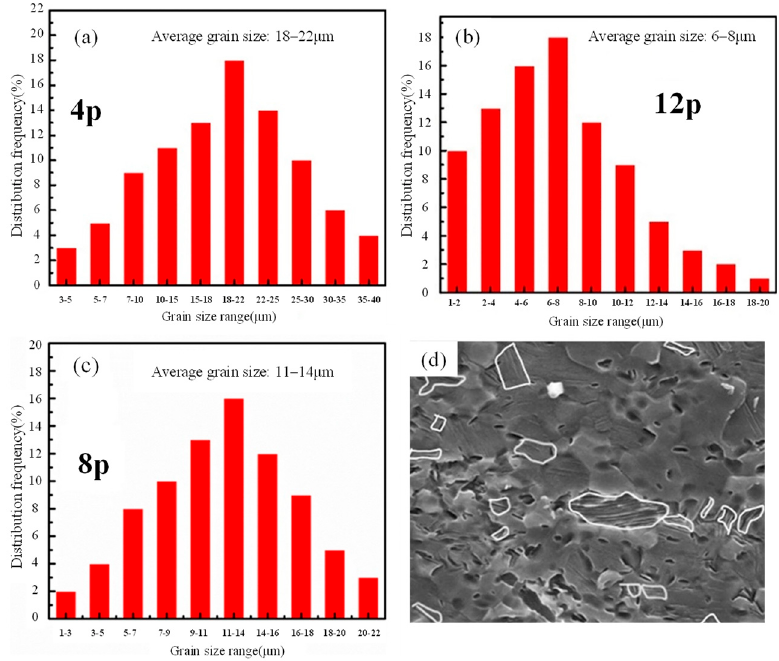
Figure 9. Grain size histogram [61]: ( a ) four passes; ( c ) eight passes; ( b , d ) is the grain size distribution map and SEM image of twelve passes. Reproduced with permission from Springer Nature.